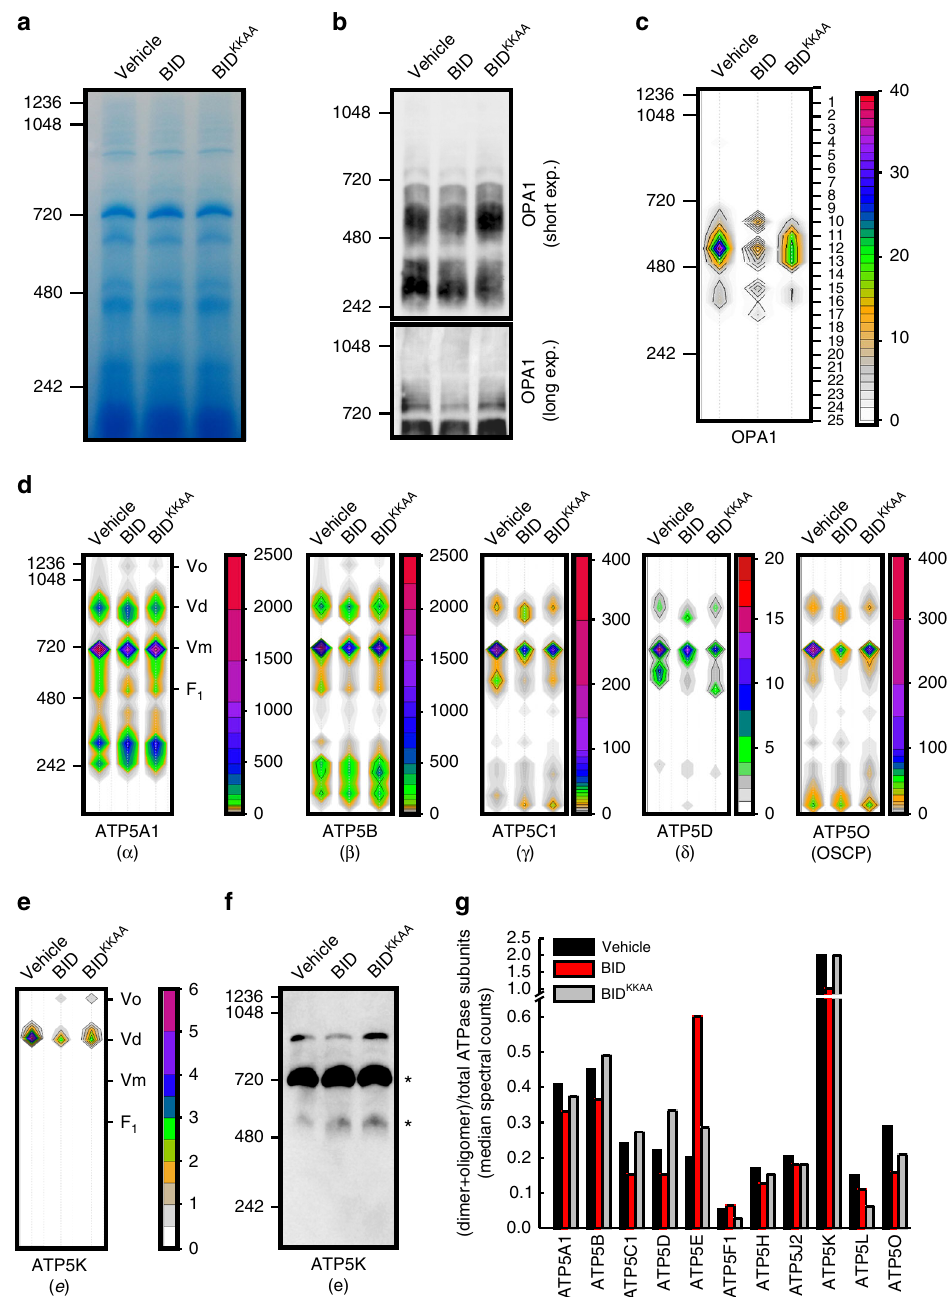
Fig. 4 ATP synthase oligomers are reduced by cristae remodeling. a , b Mouse heart mitochondria were incubated as indicated and after 30 min protein lysates (30 µ g) were separated by BNGE and Coomassie stained ( a ) or immunoblotted with the indicated antibody ( b ). c Representative color-contour plots of spectral counts of OPA1 peptides from quantitative DiS-MS analysis of extracted mitochondrial complexes. Experiments were as in a . Numbers indicate the bands excised for MS analysis. The rainbow color scale indicates the number of spectral counts. d , e Color-contour plot of spectral counts of F 1 core components ( α , β , γ , δ , OSCP, panel d) and of the F O ATPase dimerization subunit e (ATP5k) from experiments as in c . f Experiments were as in b , except that membranes were decorated with the anti-ATPase subunit e antibody. Asterisks: cross-reactive unspeci fi c bands. g Quanti fi cation of experiments as in d , e . The median values of the spectral counts of the indicated ATP synthase subunits were calculated in mitochondria pooled from three experiments performed as in a . The ratio of the median values in the dimer + oligomer region over the total forms is